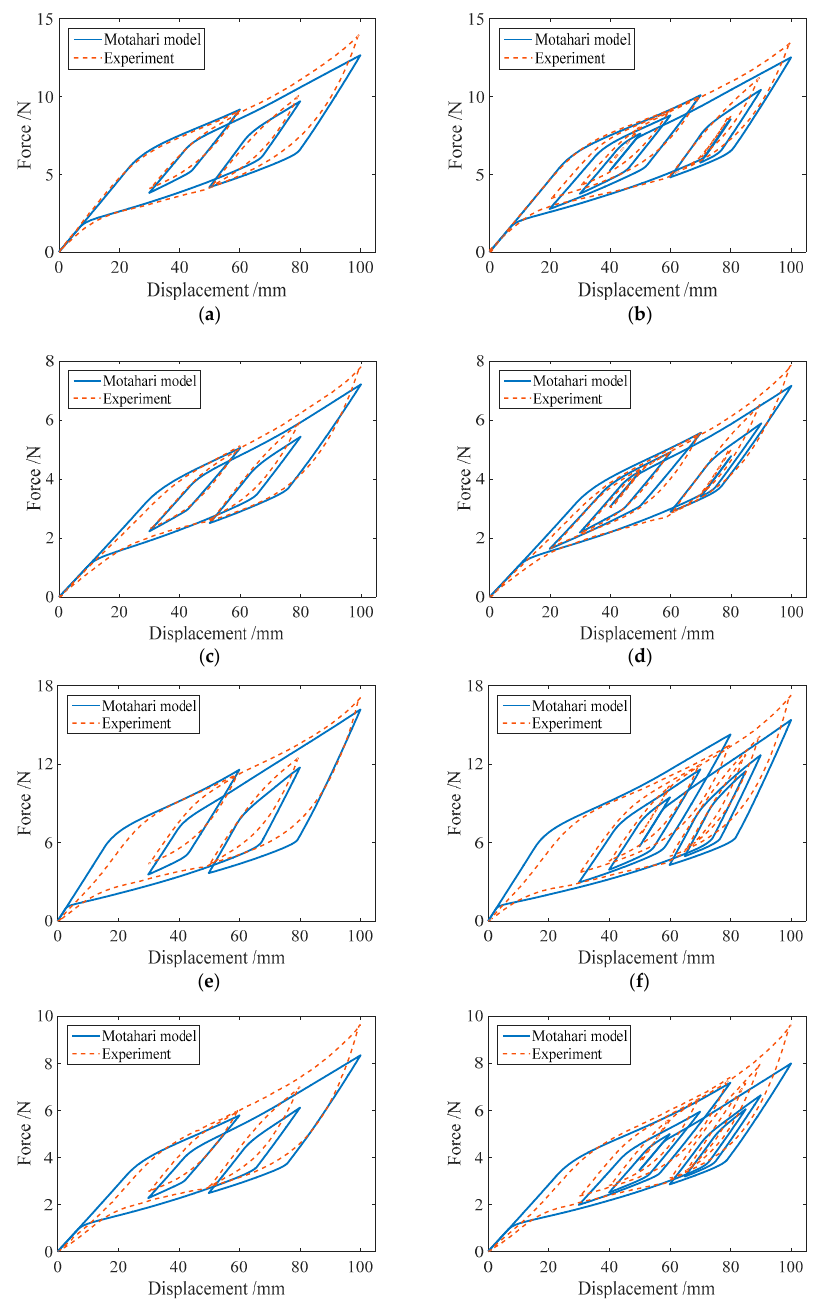
Figure 15. The numerical simulation results of the force-displacement relationship of the spring specimens from the Motahari model in the III and IV loading cases: ( a ) SMA-S1 in Case III; ( b ) SMA-S1 in Case IV; ( c ) SMA-S2 in Case III; ( d ) SMA-S2 in Case IV; ( e ) SMA-S3 in Case III; ( f ) SMA-S3 in Case IV; ( g ) SMA-S4 in Case III; ( h ) SMA-S4 in Case IV.